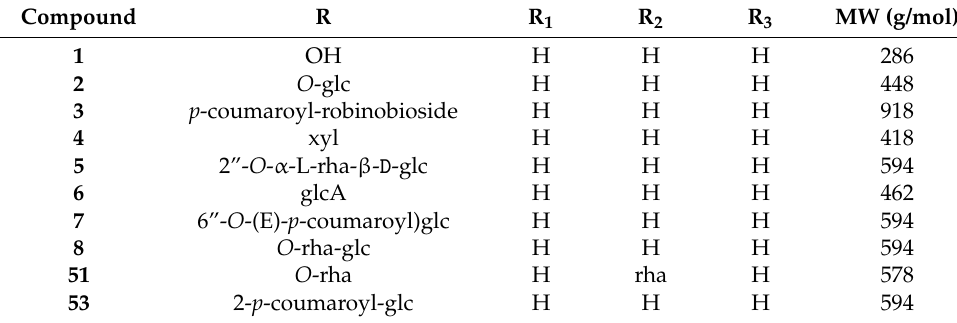
Table 1. Kaempferol and kaempferol O -glycosides.